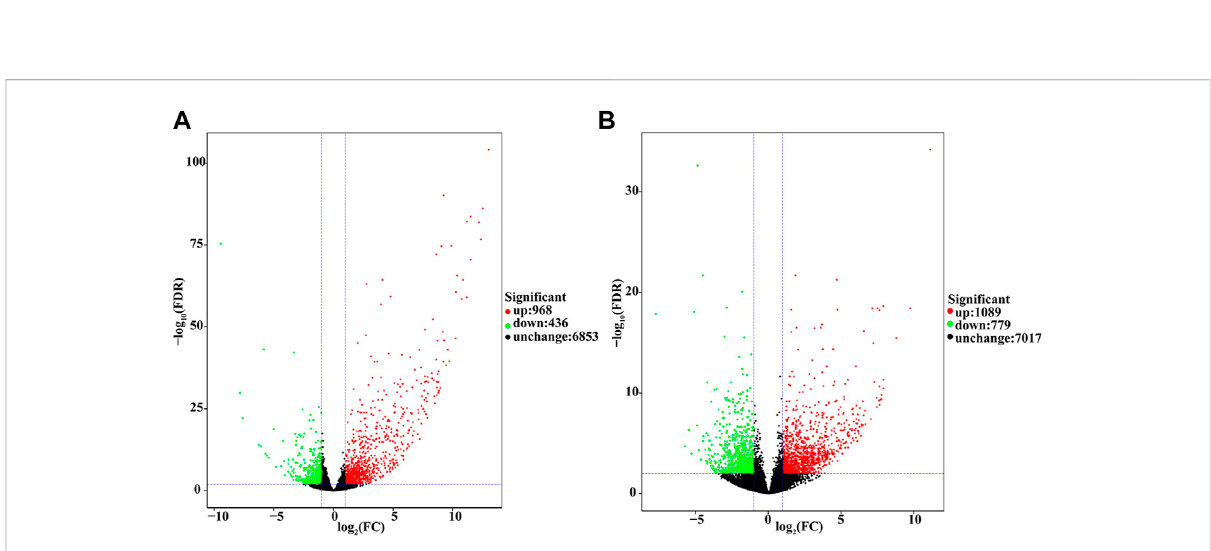
FIGURE 3 DEGsbetweencontrolandtreatmentgroupsareshowninthevolcanicmap(log10p-valuevs.log2FC).Note,Reddotsandgreendotsrepresent transcripts respectively with up-regulation and down-regulation changes. Black dots represent unchanged